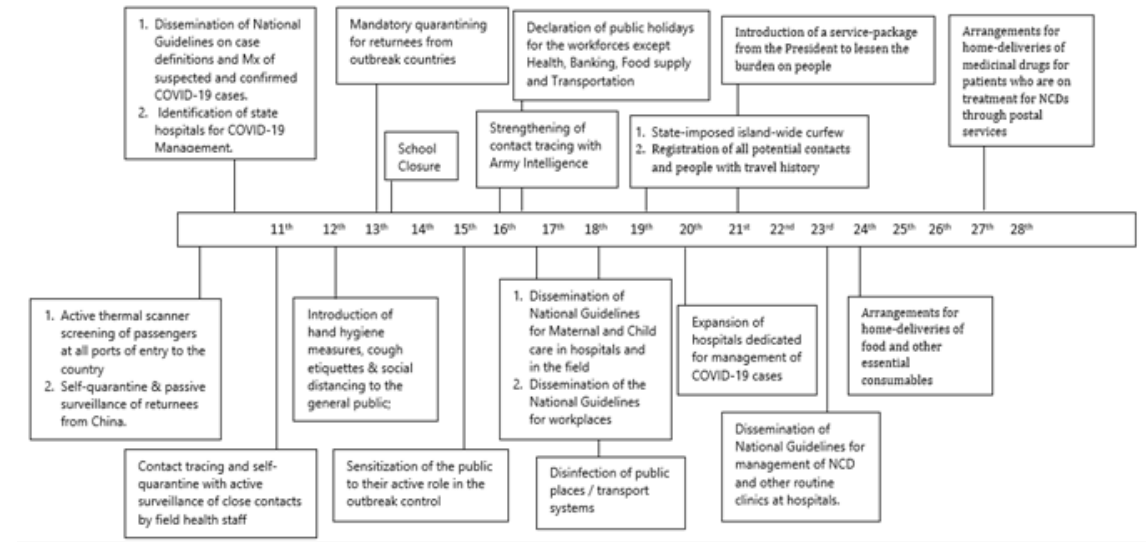
Figure 1. Timelines of health and non-health sector responses to